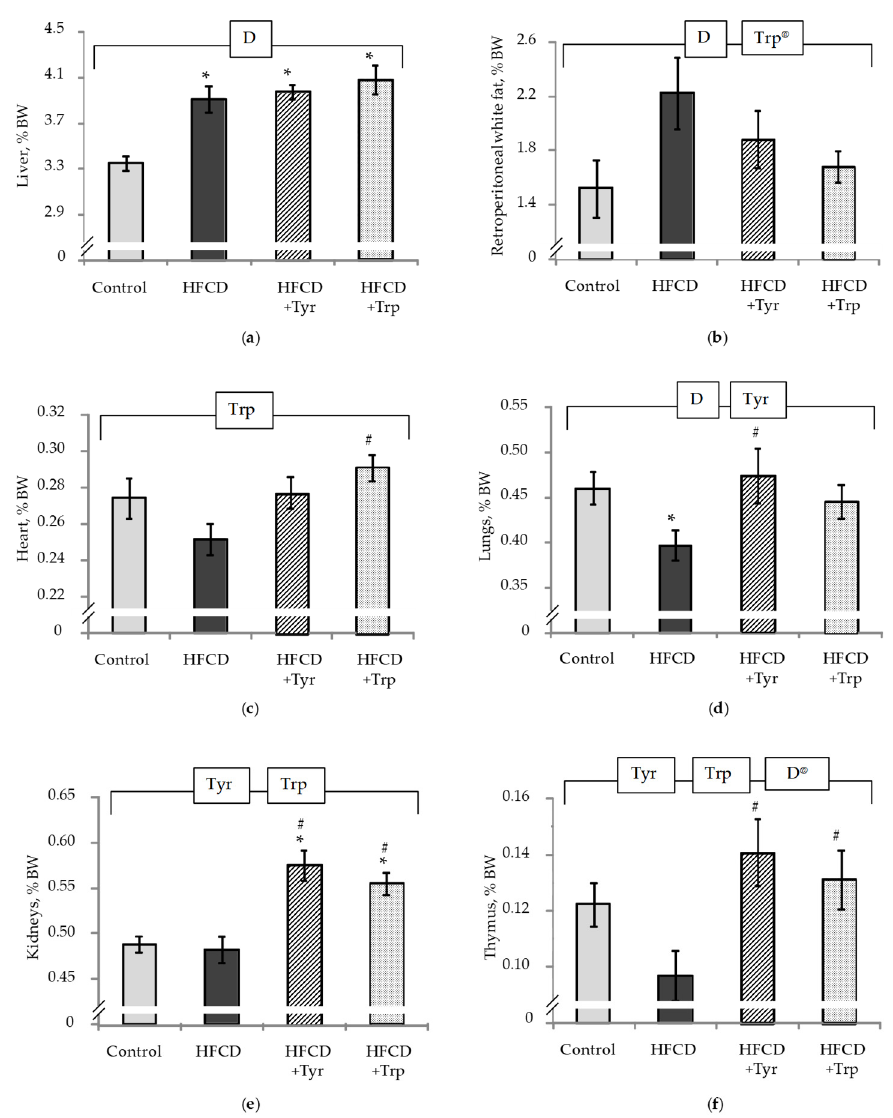
Figure 2. Weight indexes (%BW) of liver ( a ), retroperitoneal white fat tissue ( b ), heart ( c ), lungs ( d ), kidneys ( e ) and thymus ( f ), mean ± standard error of the mean. * the difference with the control group is significant; # the difference with the group receiving HFCD is significant, p < 0.05, Mann-Whitney U test. The bracket above the bars denotes significant dependence on the factors: “diet” (D), “tyrosine” (Tyr), “tryptophan” (Trp), p < 0.05, 3-way ANOVA. Index @-trend level difference, p < 0.1. The number of animals in the groups was 8.